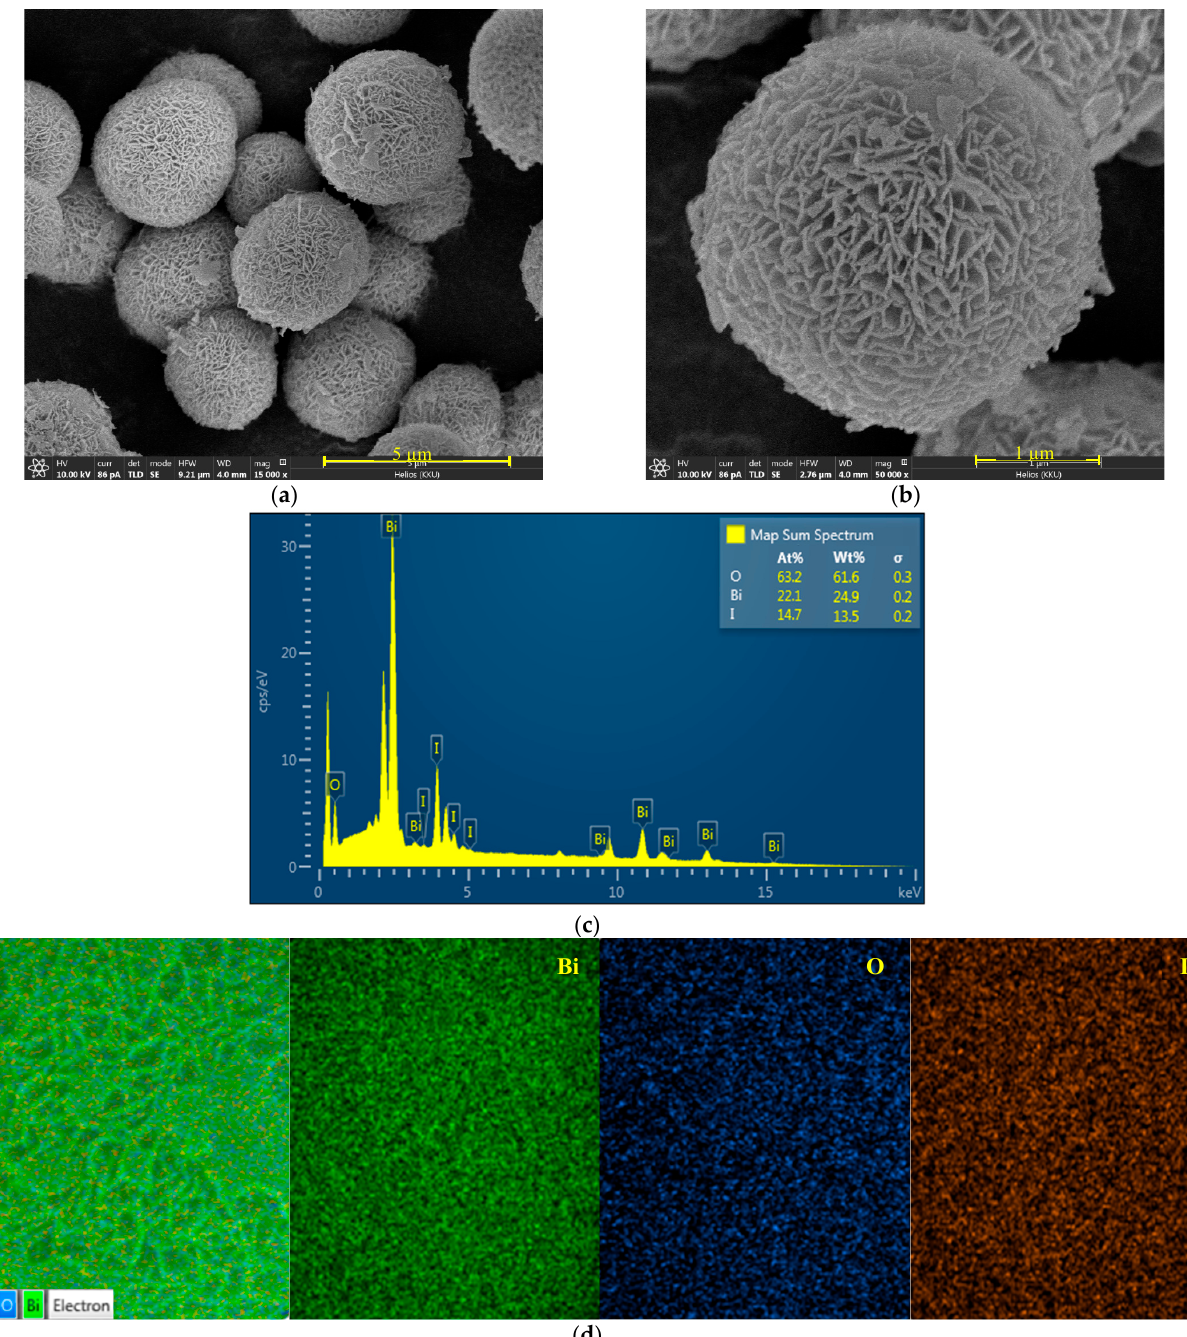
Figure 2. SEM micrographs ( a , b ); EDX spectrum ( c ); SEM micrograph of the mapping area; and EDX elementary mapping of Bi, O, and I obtained from the prepared BiOI photocatalyst ( d ).